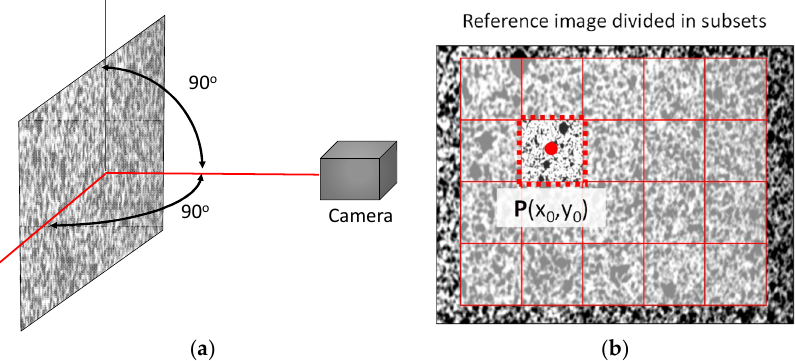
Figure 2. ( a ) Two-dimensional digital image correlation (2D-DIC) schematic set-up; ( b ) digital image correlation theory scheme.